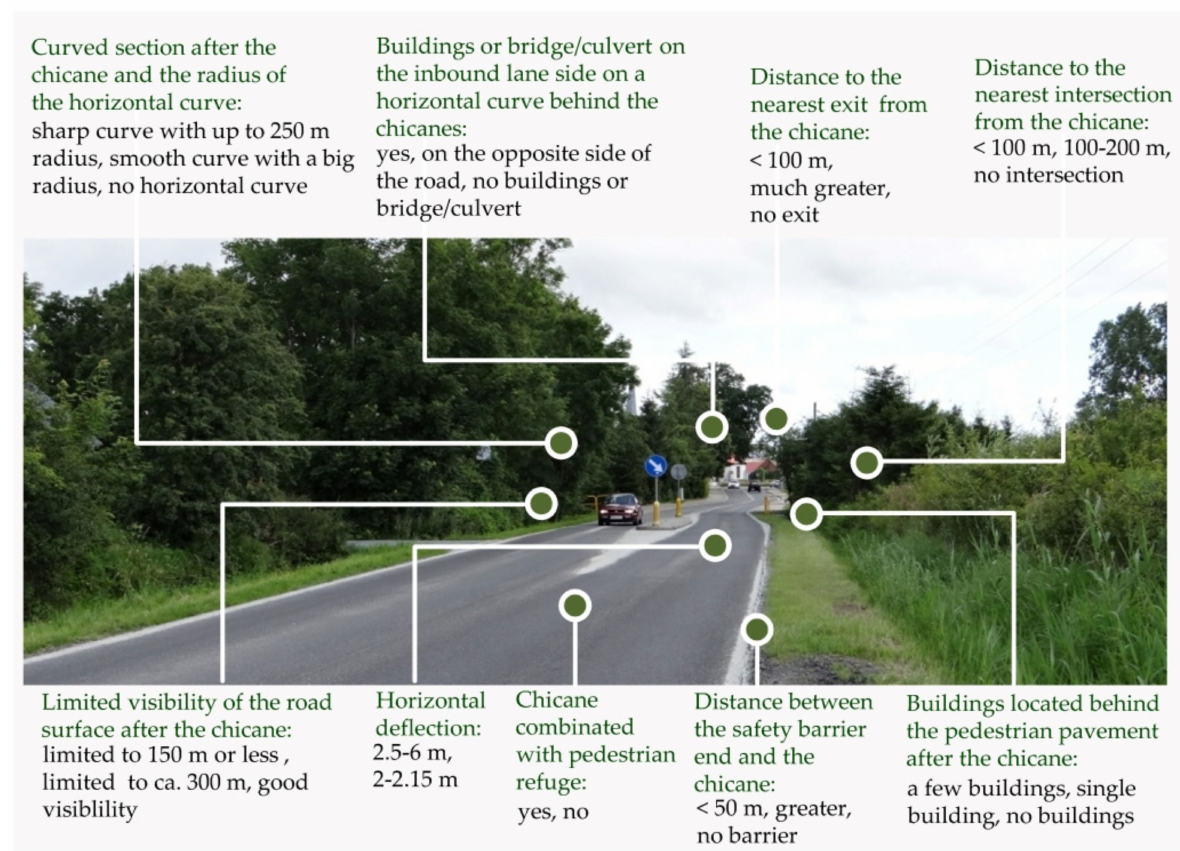
Figure 9. Factors selected for analyses, along with the assigned quantitative measures related to road design parameters. against the background image of test section No. 7. Green font designates qualitative factors and black font designates the adopted interpretation of the quantitative